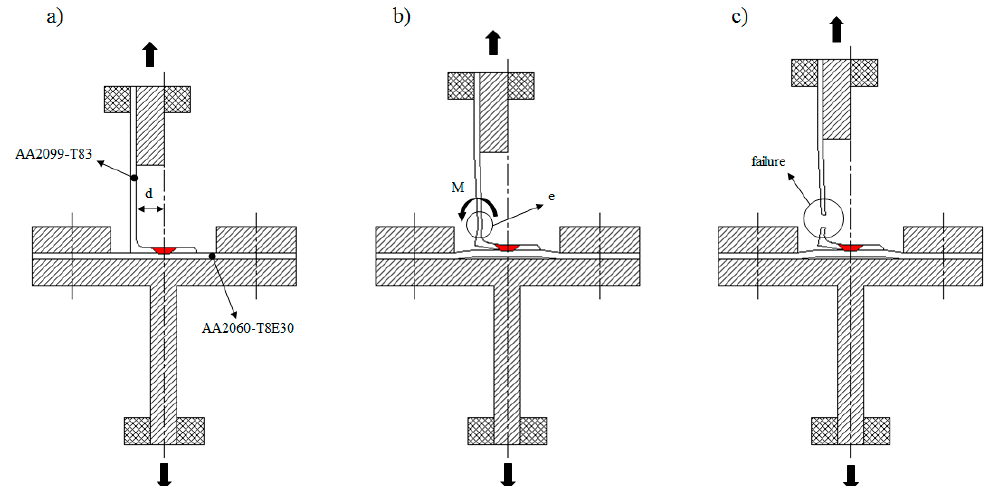
Figure 12. Representation of the progress in pull-out tests. ( a ) Test initiation; ( b ) before failure; and ( c ) after failure.